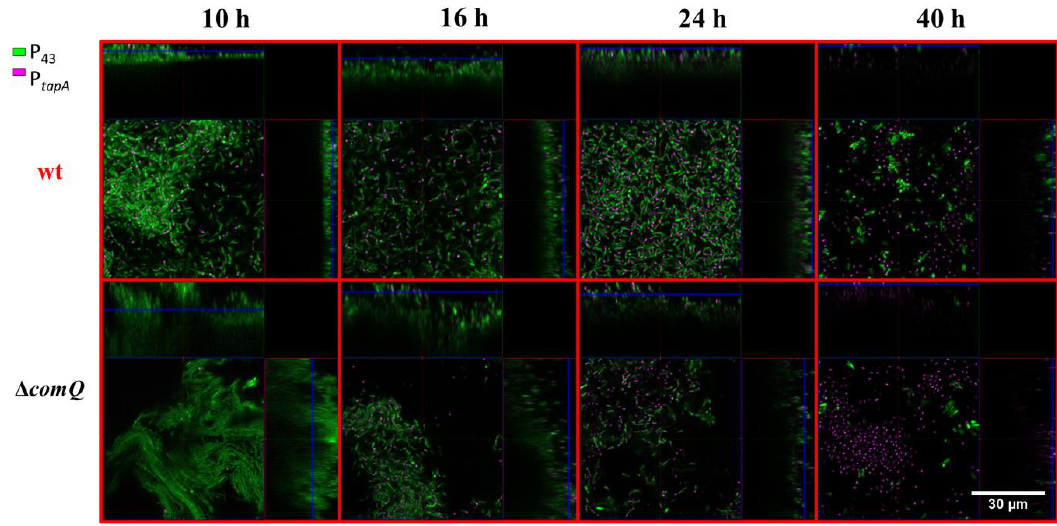
Figure 8. Confocal visualization of P spoIIQ -yfp (false-colored magenta) and P 43 - mKate2 (false-colored green) expression in wild type (wt; BM1625) and QS mutant ( Δ comQ ; BM1626) pellicle biofilms during static growth in MSgg medium at 37 °C at the indicated time points.